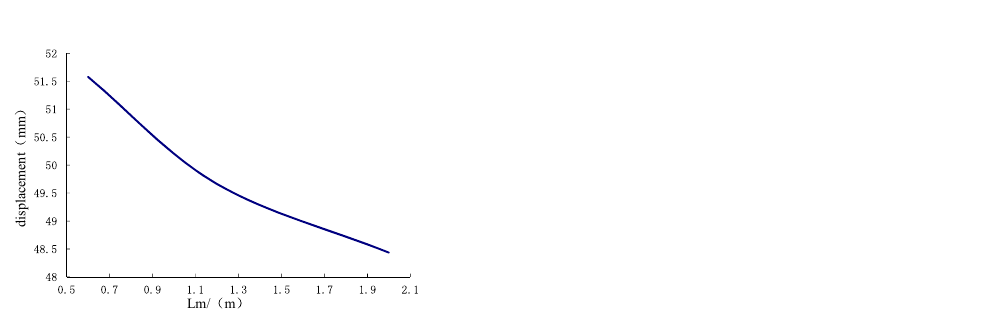
Figure 17. The effect of equivalent length L m (600–2000 mm) on the displacement of the anchor-pulling